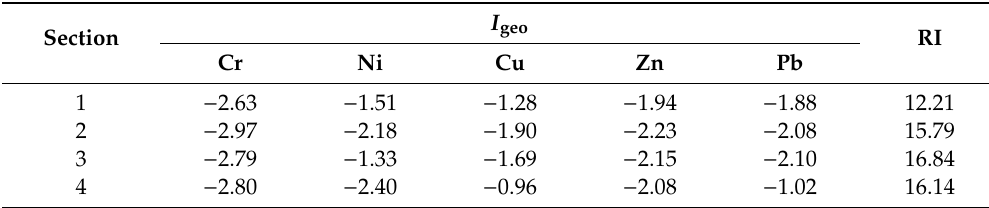
Table 5. The geo-accumulation index ( I geo ) and risk index (RI) values for the sediments of the junction of the four rivers in Linyi City.